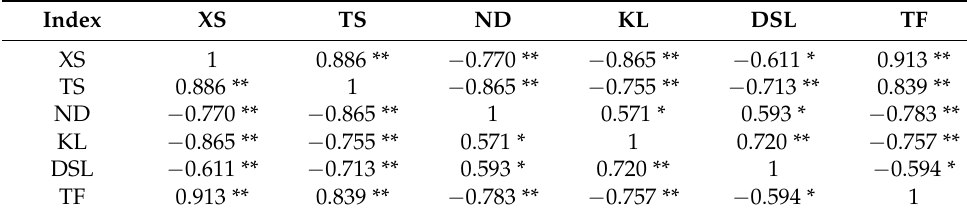
Table 1. Correlation analysis of membrane material indices.